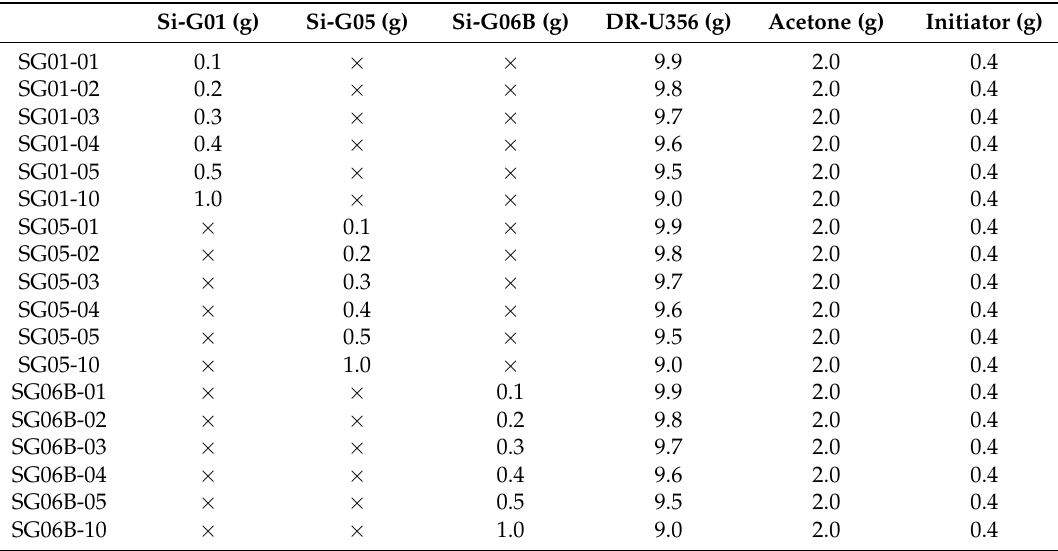
Table 1. The composition of graft fluorinated siloxane